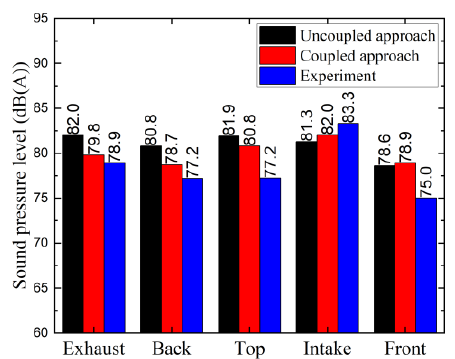
Figure 30. The sound pressure level comparisons of the five measuring points between the two simulation approaches and the measurements.